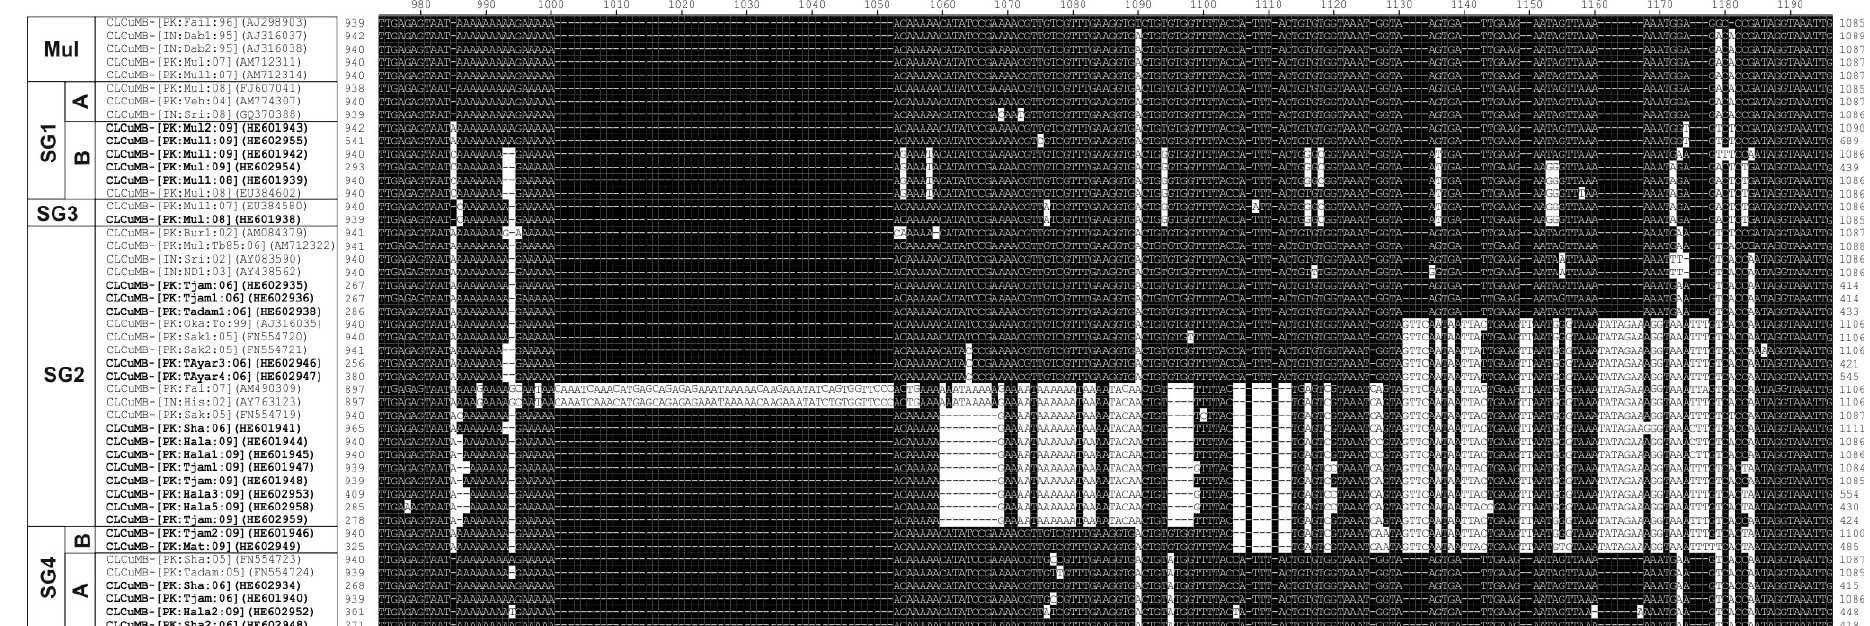
Figure 4. Alignment of the nucleotide sequences of the region between the A-rich and the SCR of CLCuMB isolates derived from the study presented here (highlighted with bold text) with selected sequences from the databases. Gaps (-) were introduced into sequences to optimize the alignment. In each case, the isolate descriptor and accession number is given. Sequences differing from CLCuMB-[PK:Fai1:96] (AJ298903; a CLCuMB Mul isolate) are highlighted as black text on a white background. The sequence groups indicated on the left are those identified in Figure